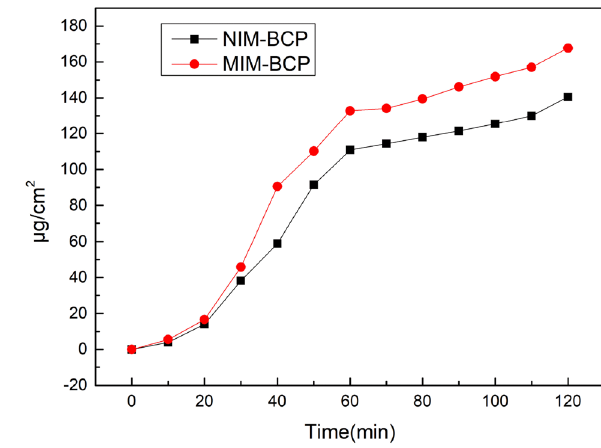
Figure 10: The in fl uence of the addition amount of template mole - cule HA on the adsorption of MIM - BCP.